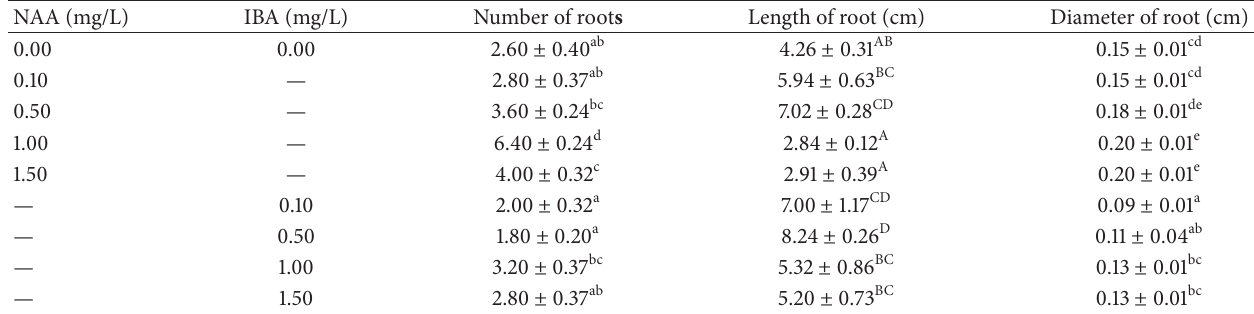
Table 8: Effects of auxin on roots induction in yellow C. crotalifera